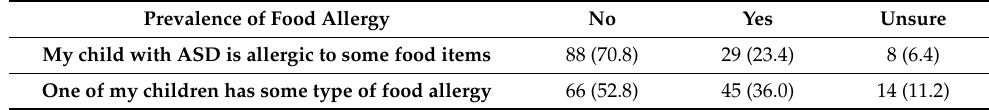
Table 2. Prevalence of food allergy in